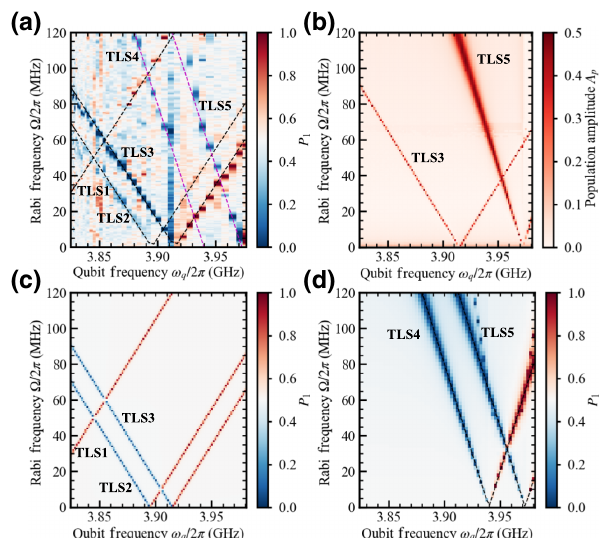
FIG. 5. (a) Experimental data shown in Figs. 4(a) and 4(b) plotted as a function of the qubit frequency ω q . Straight dashed lines represent analytic equations described in the text. (b) Results of numerical simulations of the system evolution using